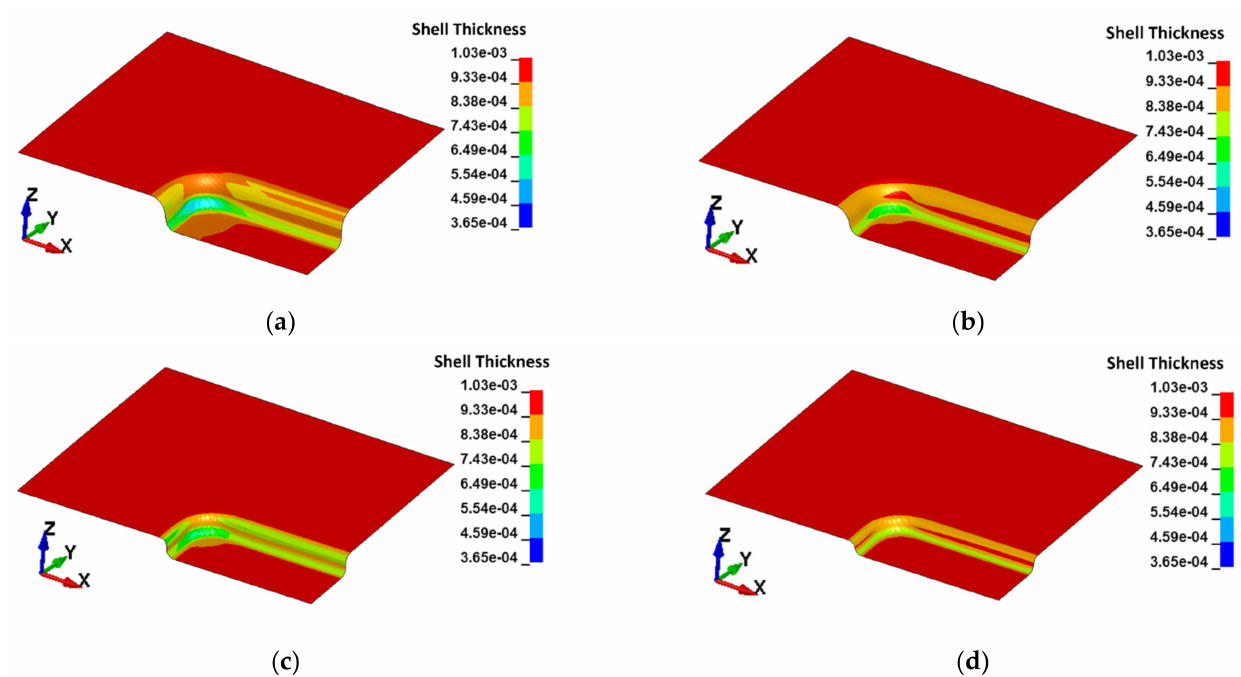
Figure 5. FLD and formability evaluation of drawing process for ( a ) CASE 1, ( b ) CASE 2, ( c ) CASE 3, and ( d ) CASE